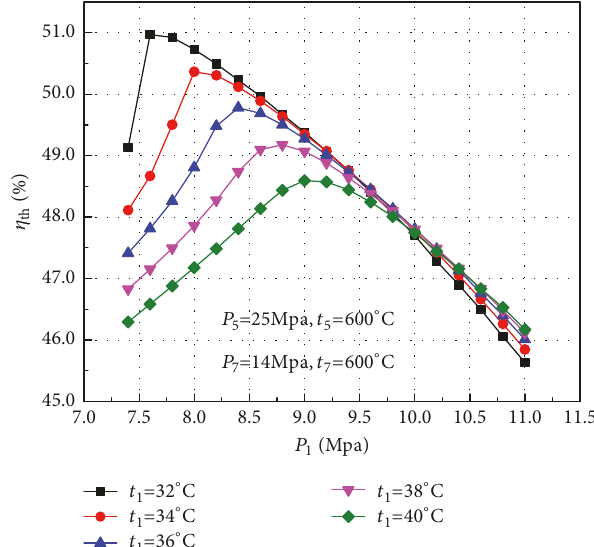
Figure12:EffectsofMCinletpressureoncycleefficiencyatdifferent MC inlet